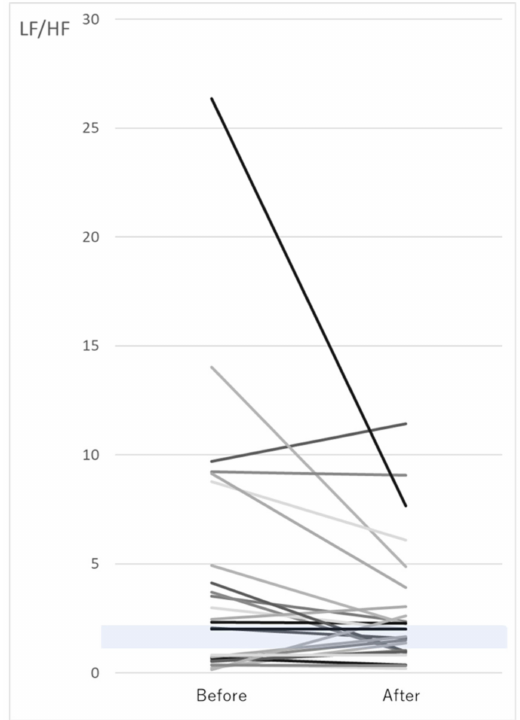
Figure 3. Changes in LF / HF; the gray zone indicates the LF / HF reference range of 0.8–2.0. Di ff erent colored lines indicate individual